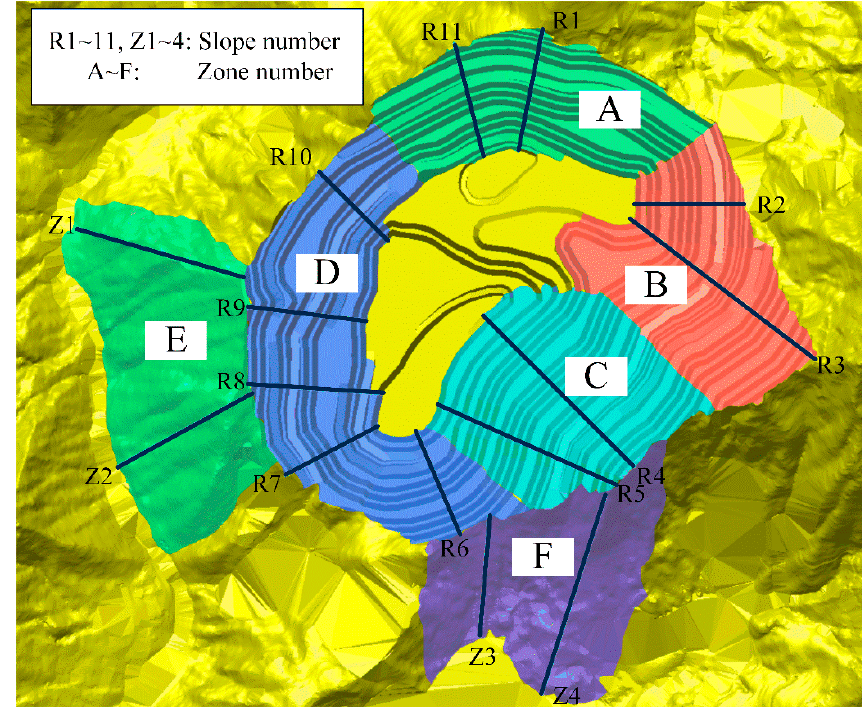
Figure 5. Diagram for mining slope zoning.